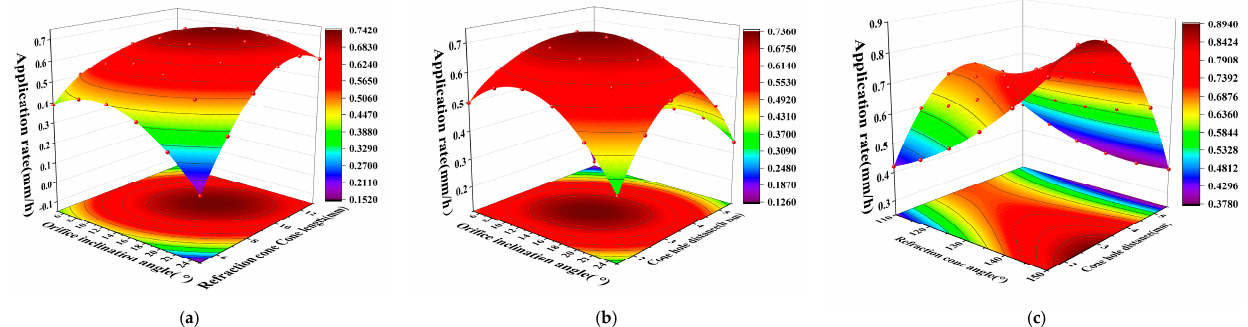
Figure 8. Two-factor interaction effect diagram of application rate. ( a ) Interaction effect between α and l . ( b ) Interaction effect between α and h . ( c ) Interaction effect between θ and h .